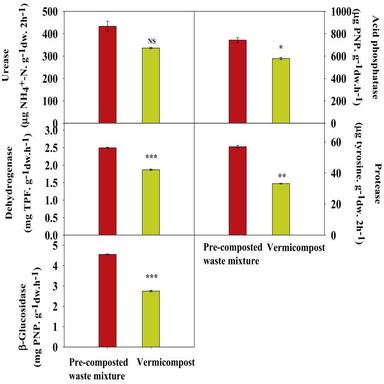
Changes in enzymatic activities of pre-composted waste mixture and final vermicompost, Level of statistically important difference at p < 0.05 (\), p < 0.01 (\\), p < 0.001 (\\\) and NS (non-significant) by Paired Student's t-test.